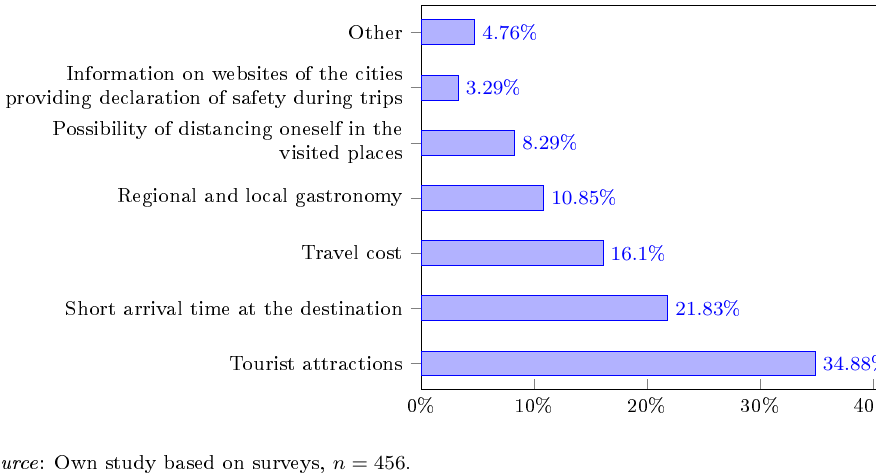
Figure 2: Length of the holiday trips as a part of urban tourism